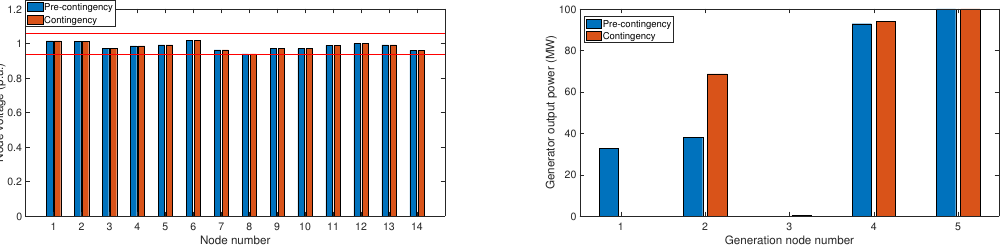
Figure 16. Voltage and power dispatched in the extended power system with PV generation prior to and after contingency of branch 10 (generation nodes are, respectively, nodes 1, 2, 3, 6, and 8).